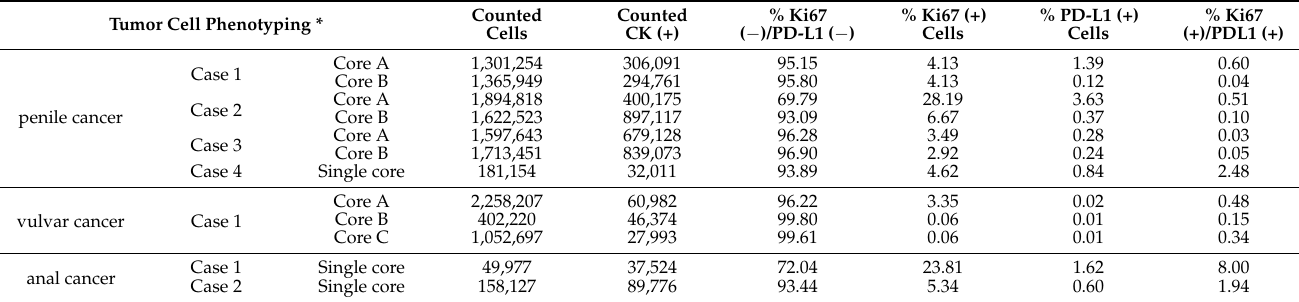
Table 2. Tumor cells phenotyping and multiple biomarker